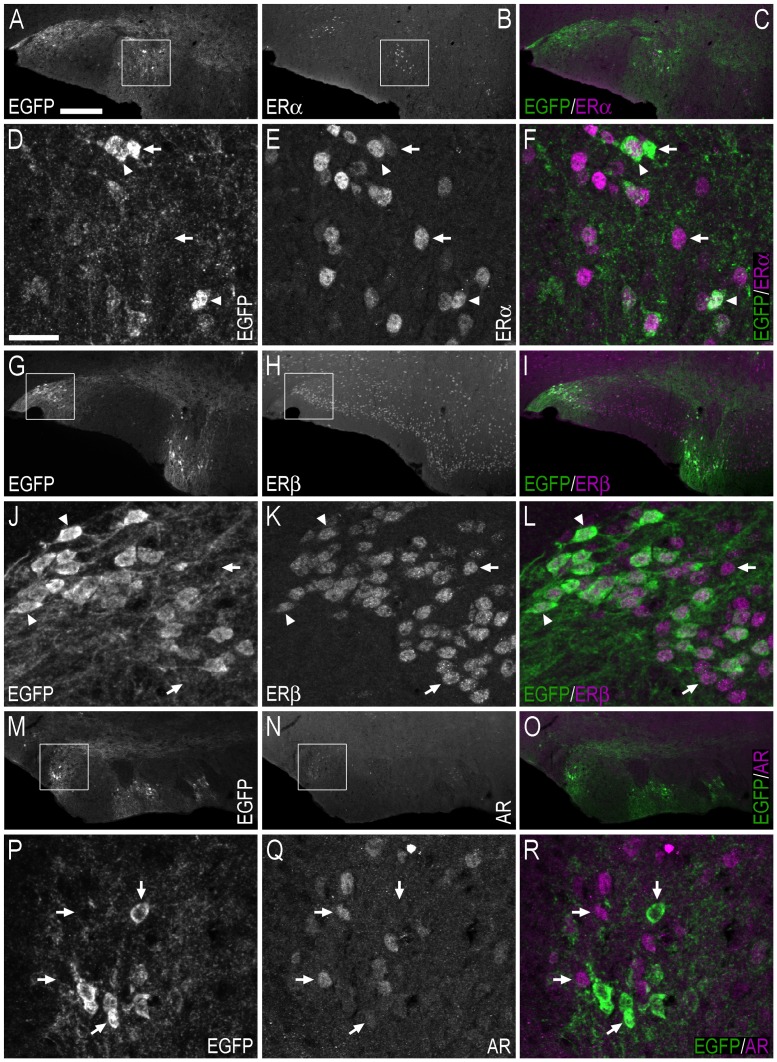
Double-immunofluorescence photo and confocal micrographs showing the distribution of EGFP-, ERα−, ERβ-, and AR-LI at the level of the olfactory tubercle.(A–C) Single-channel photomicrographs of double-fluorescence immunohistochemistry (C), showing EGFP− (A) and ERα-LI (B) (Bregma, +0.38 mm). (D–F) Single-channel confocal micrographs of double-immunofluorescence (F), displaying EGFP− (D), and ERα-LI (E). The confocal micrographs in (D–F) are magnified views from the white squares shown in (A) and (B). (G–I) Single-channel photomicrographs of double-fluorescence immunohistochemistry (I), showing EGFP− (G) and ERβ-LI (H) (Bregma, +0.38 mm). (J–L) Single-channel confocal micrographs of double-immunofluorescence (L), displaying EGFP− (J), and ERβ-LI (K). Confocal micrographs in (J–L) are magnified views of the white squares shown in (G) and (H). (M–O) Single-channel photomicrographs of double-fluorescence immunohistochemistry (O), showing EGFP− (M) and AR-LI (N) (Bregma, +1.42 mm). (P–R) Single-channel confocal micrographs of double-immunofluorescence (R), displaying EGFP− (P), and AR-LI (Q). Confocal micrographs in (P–R) are magnified views of the white squares shown in (M) and (N). In D–F, J–L and P–R, arrows point to single labelled cell bodies, and arrowheads point to double-labelled cell bodies. Scale bars: A = 200 µm, applies A–C, G–I, M–O; D = 25 µm, applies D–F, J–L, P–R.